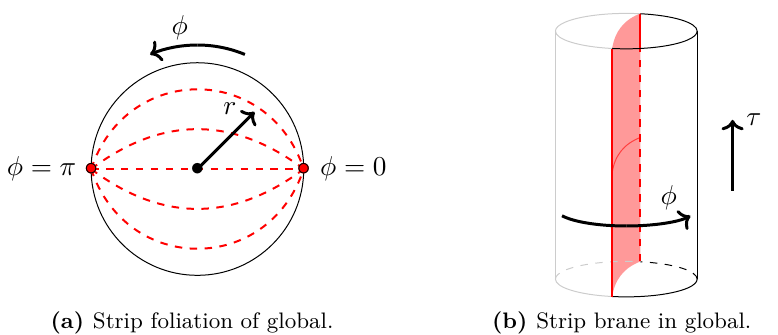
Figure 21. (a) The strip foliation of Euclidean pure AdS d +1 in global coordinates, projected onto the ( r, φ ) disk. The leaves anchor to antipodal points on the conformal boundary. (b) The bulk configuration obtained by selecting a leaf of the strip foliation as an end-of-the-world KR brane (in red), with the transverse ( ψ 1 , . . . , ψ d − 2 ) coordinates fixed. We excise the part of the bulk to the “left” the